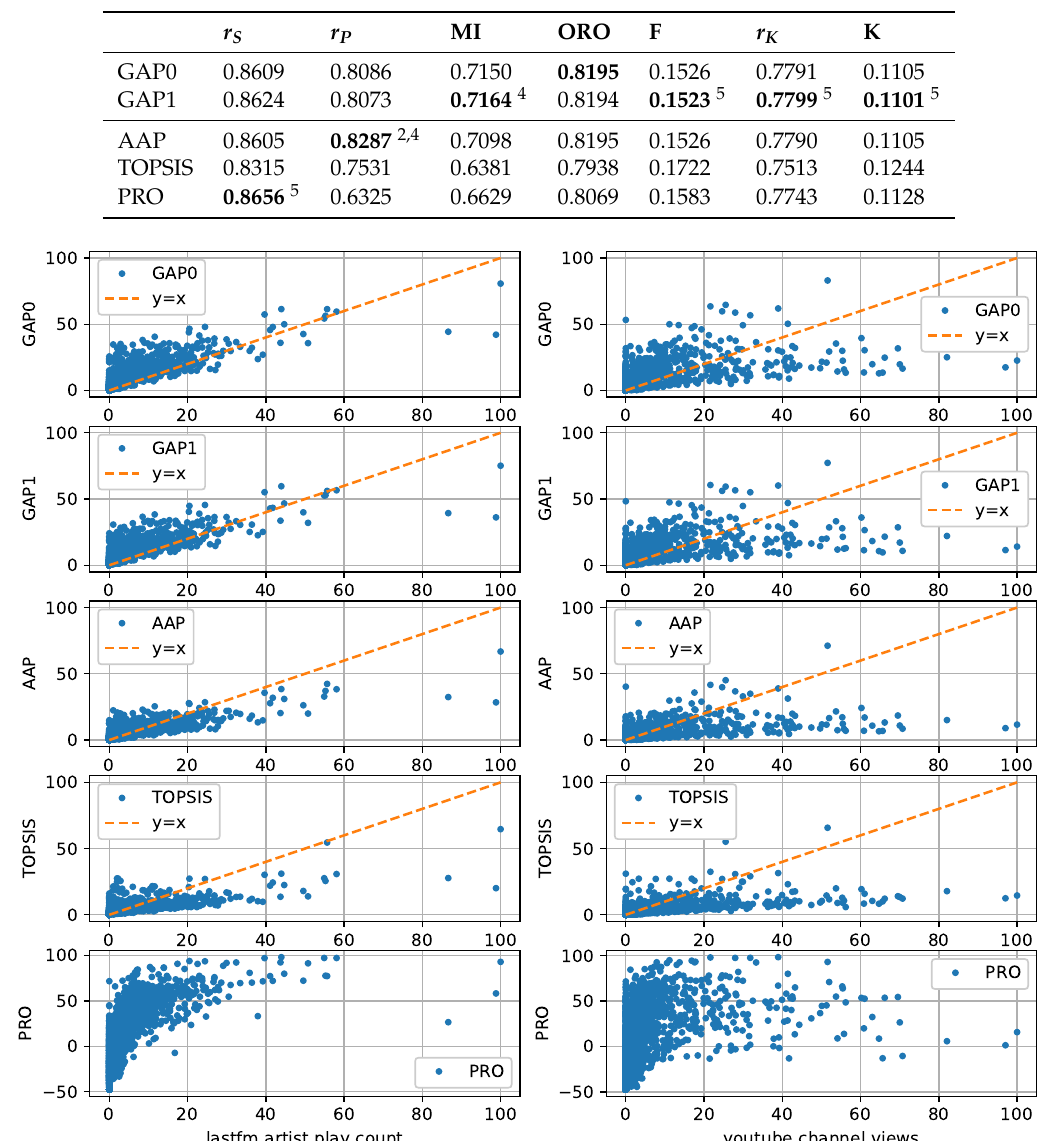
Table 4. Measures of similarity between the target variable (Last.fm artist plays) and the aggregation methods (AAP, GAP0, GAP1, TOPSIS, PRO) in 2 April 2019. With bold, we denote the best performance per measure of similarity (column). With the exponents, we denote the best similarity scores for which their difference from the 2nd, 3rd, 4th, or 5th best, respectively, is statistically significant (95% confidence). For r P , the first number in the exponent concerns Zoo’s method, while the second concerns the randomization test. ORO, Overall Rank Overlap; F, Spearman’s Footrule distance.